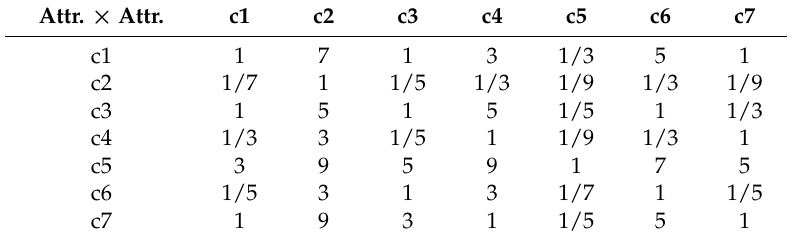
Table 2. Problem Dataset 2 (Matrix B ): pairwise comparison matrix (Data source: [4]). Attr. ×